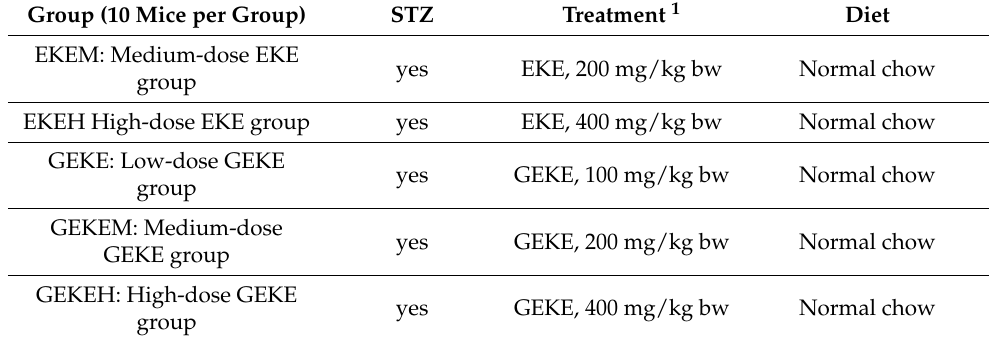
Table 1. Cont . Group (10 Mice per Group) STZ Treatment 1 Diet EKEM: Medium-dose EKE yes EKE, 200 mg/kg bw Normal group